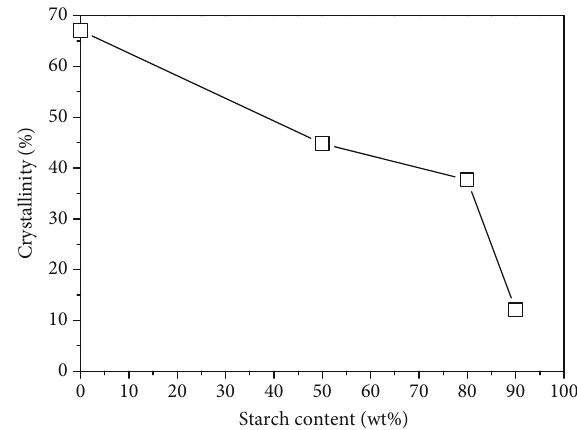
Figure 4: The X of polyethylene for starch-based composite fi c